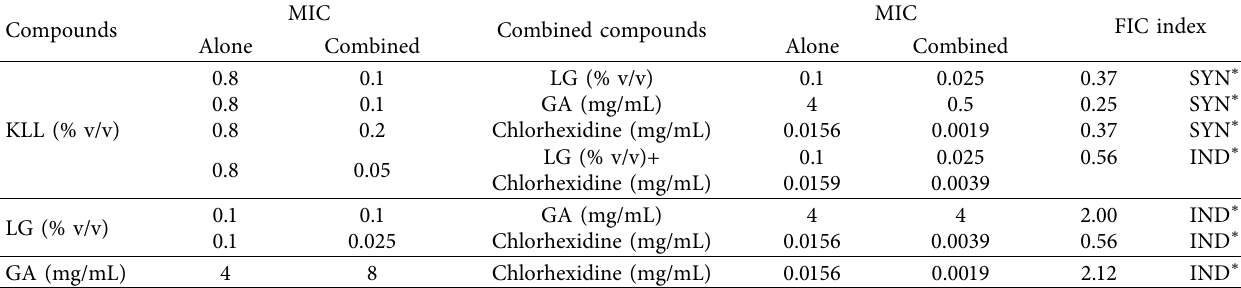
Table 4: FIC indexes of the combination of chlorhexidine, GA, and EOs against S. mutans ATCC 25175. MIC Compounds Combined